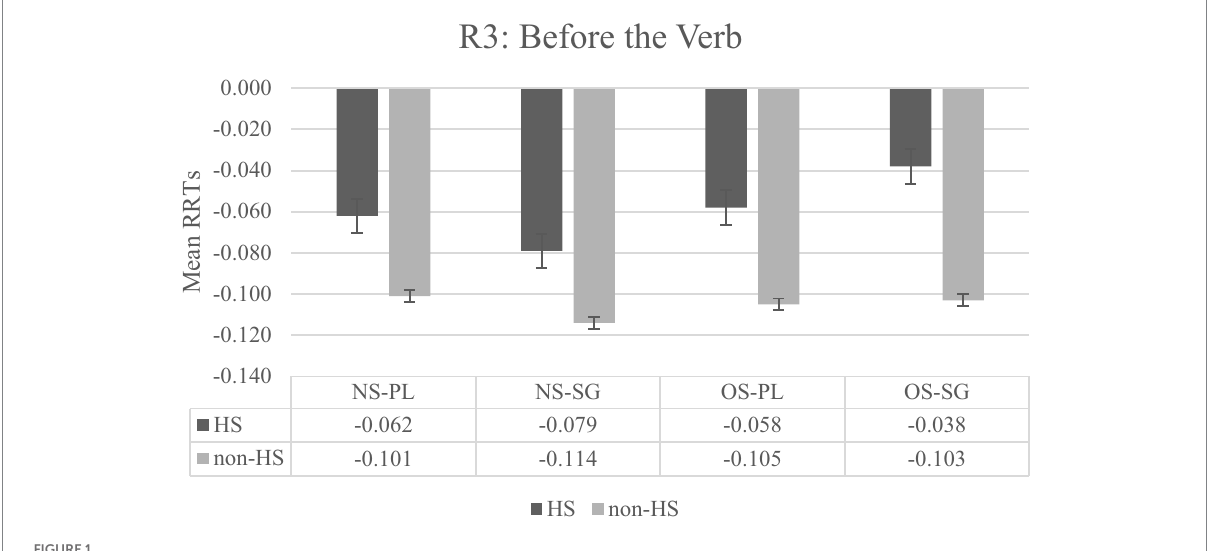
FIGURE 1 Mean RRTs of both groups for Region 3 (Before the verb). RRTs, Residual reading times; HS, Heritage speakers; non-HS, Non-heritage speakers; NS, Null subject; OS, Overt subject; PL, Verb is plural-marked; SG, Verb is unmarked.